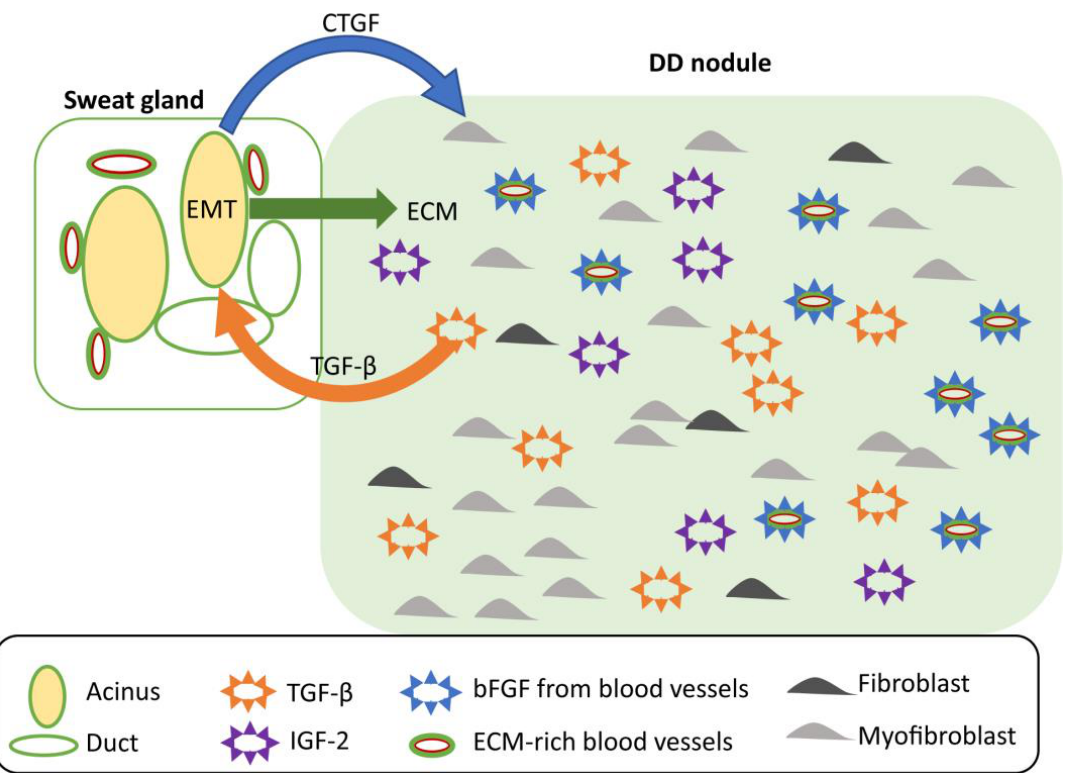
Figure 5. Schematic model summarizing the proposed role of sweat glands in the pathogenesis of DC. See discussion for more details.